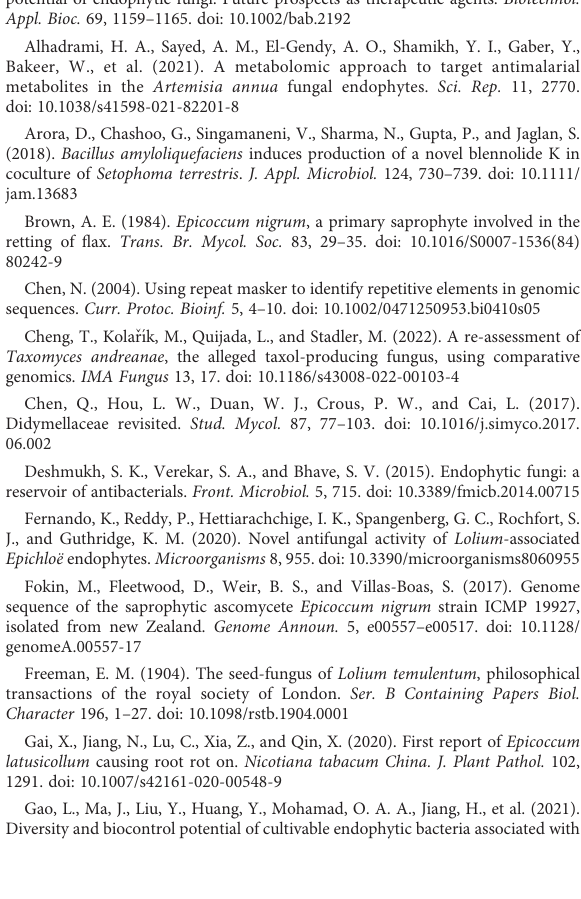
SUPPLEMENTARY FIGURE 2 Maximum likelihood phylogram and genome statistics of Epicoccum species analysed in this study. The genome accession numbers of Ep. latusicollum (HGUP191049 and T41), Ep. nigrum (cf0051 and ICMP 19927), Ep. sorghinum (BS2-1 and USPMTOX48), and Didymella exigua (CBS 183.55) are JANURY000000000, JACCMO000000000, JAASLF000000000, NCTX00000000, VXJJ00000000, MIEO00000000, and VOSY00000000, respectively. SUPPLEMENTARY FIGURE 3 Putative oxyjavanicin in Epicoccum latusicollum HGUP191049. a. Oxyjavanicin structure b. Schematic representation of the putative BGC of oxyjavanicin (cluster 11). TD : thioesterase domain, KS : ketosynthase, AT : acyl transferase, PT : product template, T1PKS : type I polyketide synthases. SUPPLEMENTARY FIGURE 4 Putative squalestatin S1 in Epicoccum latusicollum HGUP191049. (A) Squalestatin S1 structure (B) Schematic representation of the putative BGC of squalestatin S1 (cluster